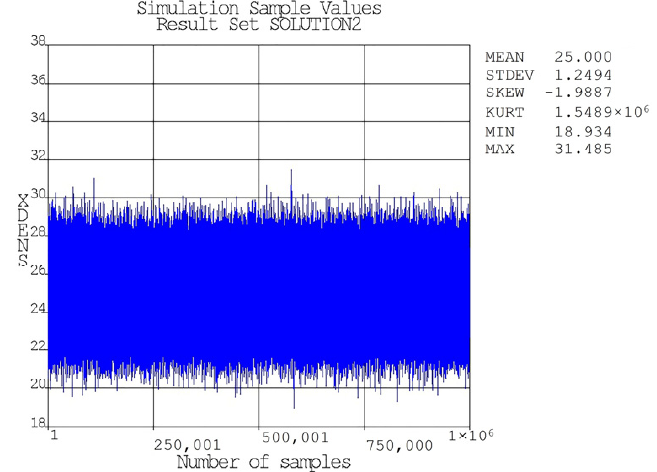
Figure 20. XDENS random sampling.